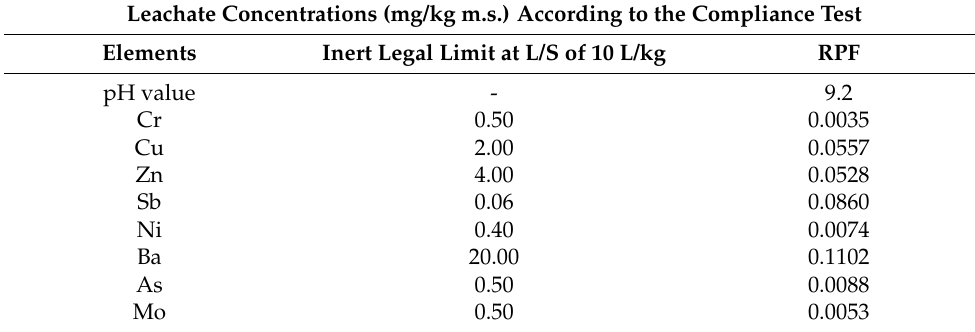
Table 2. Leachate concentrations (mg/kg m.s.) from RPF by UNE-EN